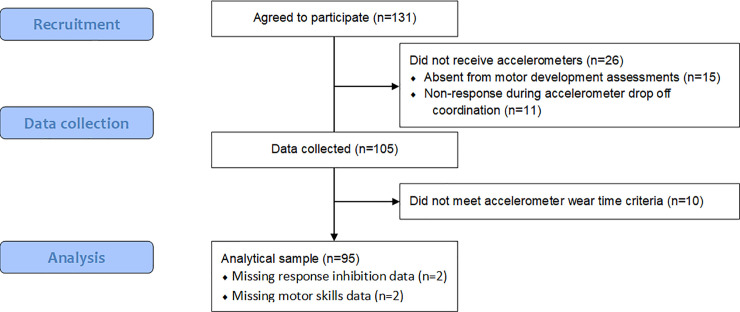
Participant flow diagram.